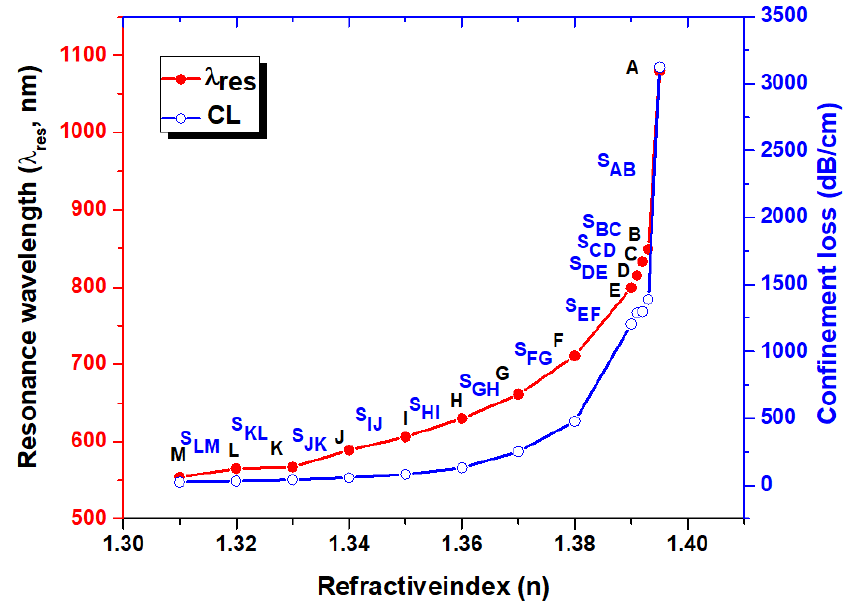
Figure 11. Resonance wavelength (nm) and confinement loss spectra of the core-guided mode for different analytes ( n ana ) ranging from 1.31 to 1.3950.